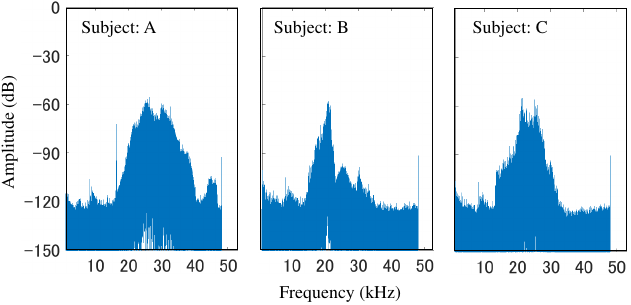
Figure 5. Examples of different inclusion properties of ultrasonic components in recorded sounds.